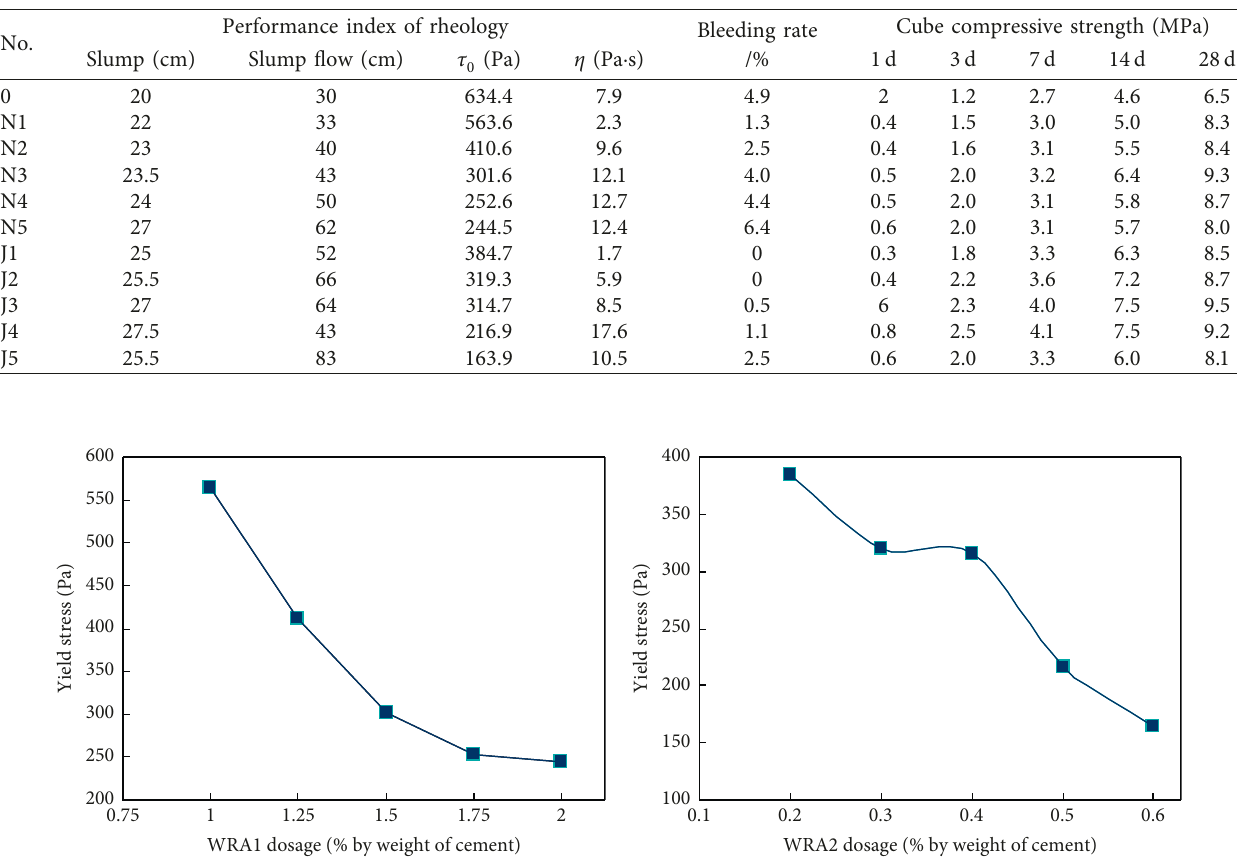
Table 4: Performance indicators of CGCBM.